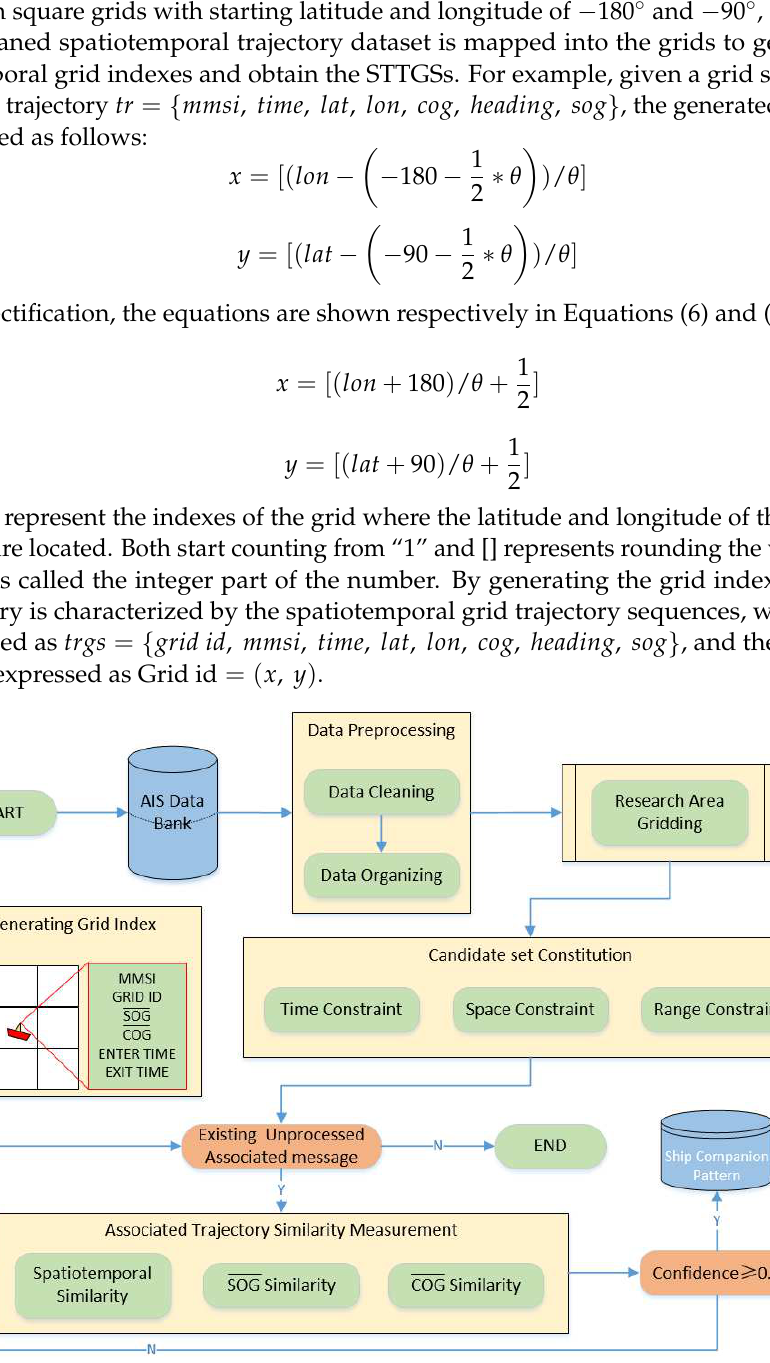
Figure 2. The detailed process of the